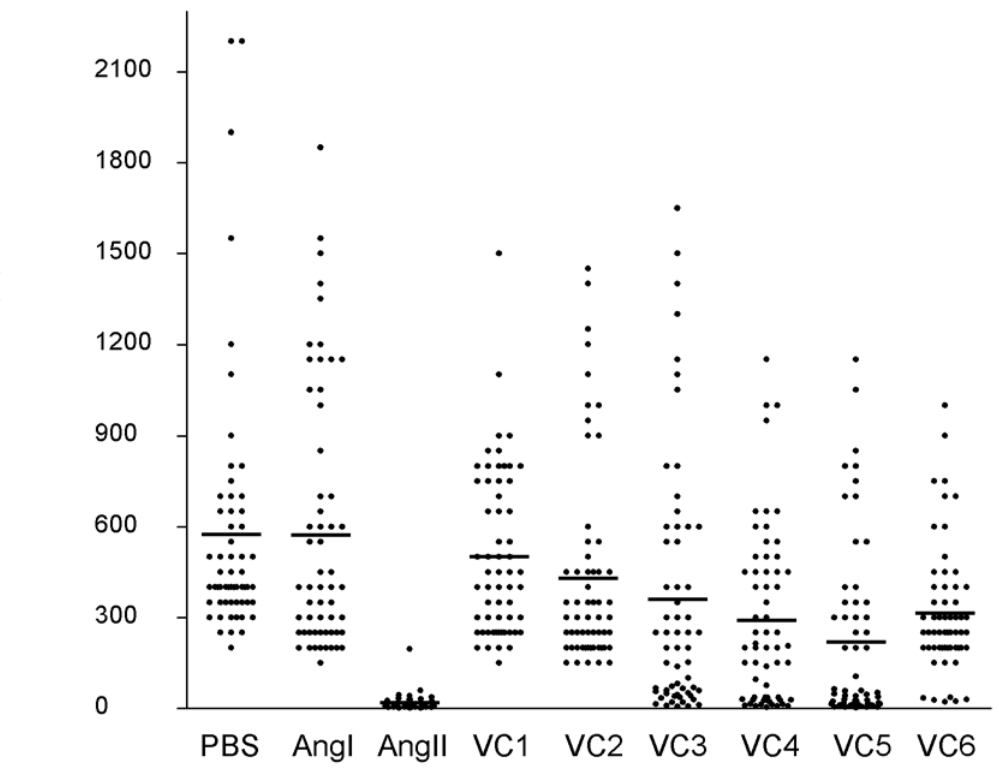
Figure 1. Numbers of sporozoites in salivary glands of angiotensin I-, angiotensin II- or synthetic peptide-treated Ae.aegypti. At day 7 post-infection 0.5 m l of ang I (60 m M), ang II (60 m M), VC1 (60 m M), VC2 (60 m M), VC3 (60 m M), VC4 (60 m M), VC5 (60 m M), VC6 (60 m M) and PBS (control) were microinjected intrathoracically on anesthetized Ae.aegypti . Salivary glands were dissected 24 hours after the microinjection and sporozoites counted. Kruskal–Wallis tests indicated significant effects ( p , 0.0001 and p , 0.001) of the peptides in the number of salivary glands sporozoites for ang II and VC5, respectively. VC1, VC2, VC3, VC4, VC6 did not significant effect ( p . 0.05).